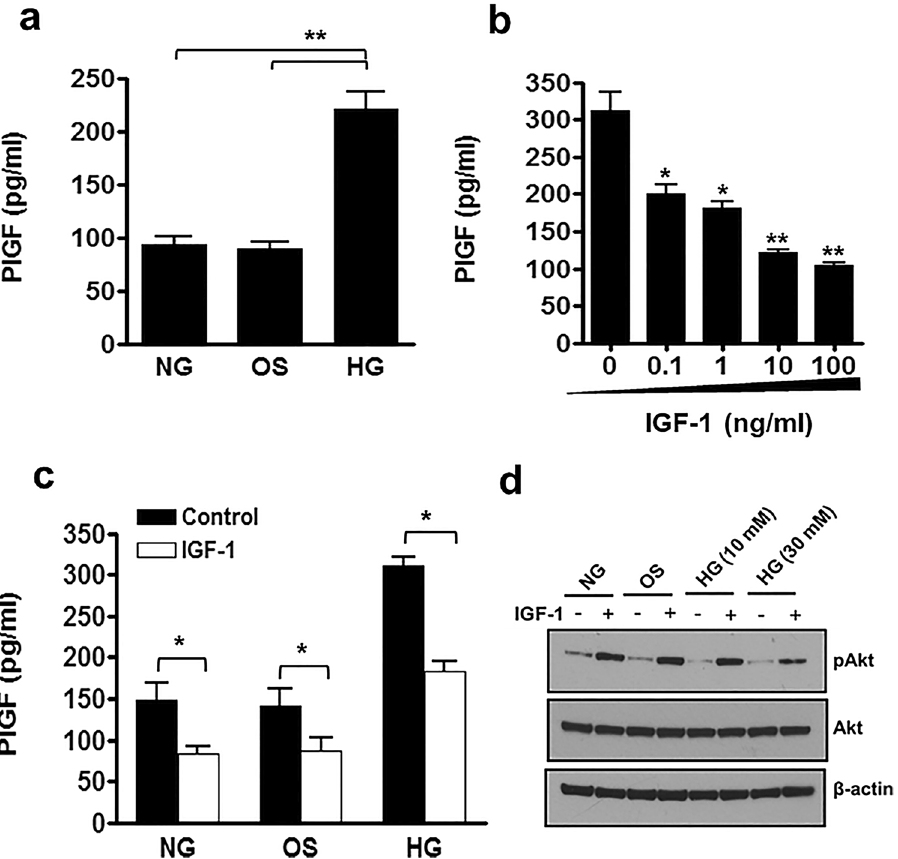
Figure 1. Hyperglycaemia suppresses Akt activity and promotes PlGF secretion in endothelial cells. ( a ) Confluent endothelial cells cultured for 24 h in either normolycaemia (NG = 5 mM d-glucose), hyperglycaemia (HG = 30 mM d-glucose) or osmolarity control (OS = 5 mM d-glucose + 25 mM l-glucose) medium, and the level of PlGF secretion measured by ELISA. ( b ) Confluent HUVEC stimulated with increasing concentrations of IGF-1 in medium containing 10% FCS for 24 h and PlGF secretion measured by ELISA. ( c ) HUVEC were cultured in medium containing either NG, HG or OS control in the presence of IGF-1 (10 ng/ml) for 24 h and PlGF secretion quantified by ELISA. ( d ) Confluent HUVEC were maintained in NG, HG or OS control conditions and then stimulated with IGF-1 (10 ng/ml) or vehicle for 10 min and cell lysates Western blotted for Figure S5. Results are the mean ± SEM of 3 or more independent experiments; Student’s t-test *P < 0.05, **P <